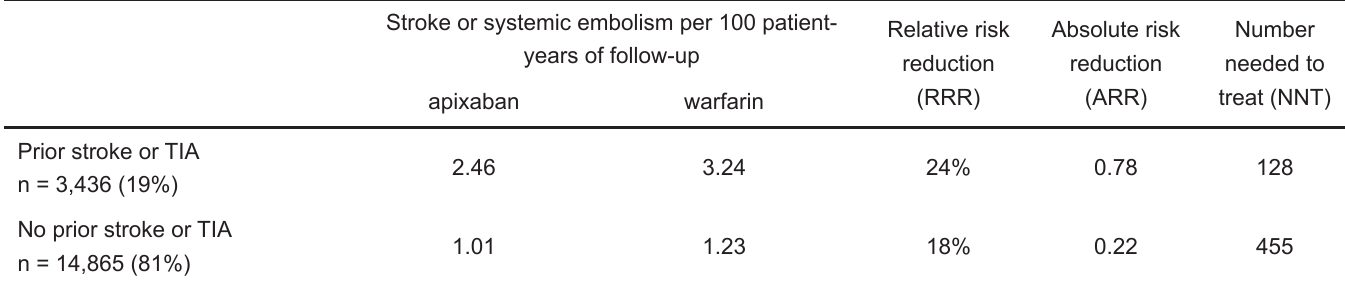
Table 1 . ARISTOTLE 11